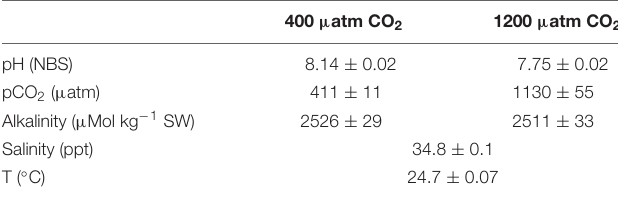
TABLE 1 | Experimental conditions and seawater physicochemical